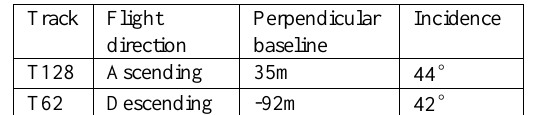
Table 1. Interferograms used for the 2017 Jiuzhaigou 7.0 Event The resulting line-of-sight (LOS) displacement is shown in Figure 2. In order to make the computation feasible and